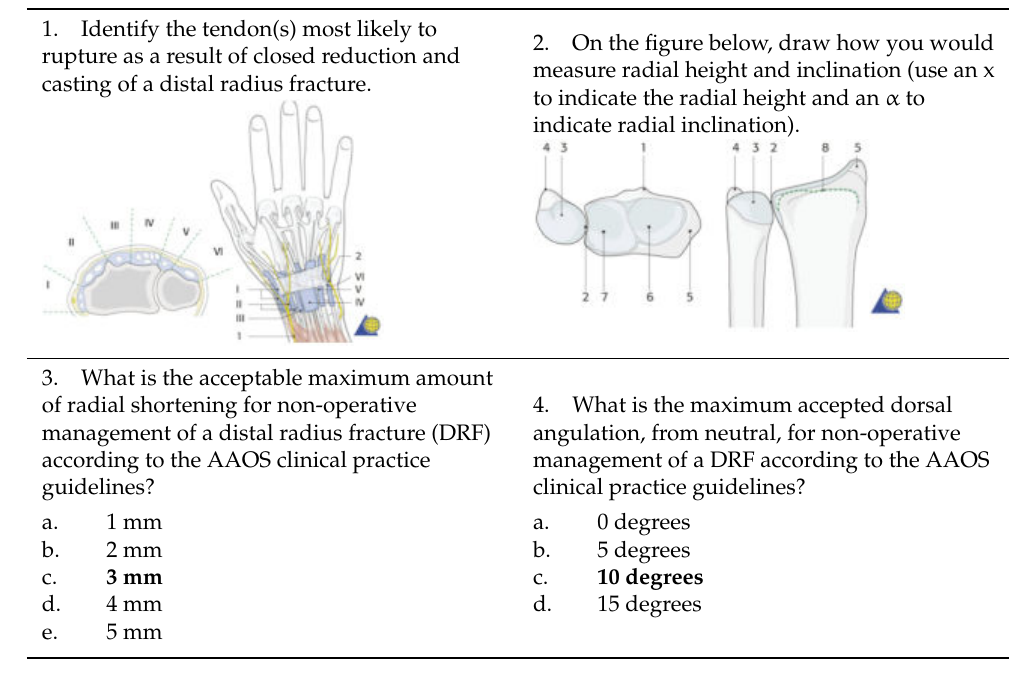
Table A1. Written examination given to trainees following the performance of distal radius fracture management on the phantom, correct responses to multiple choice questions are bolded, adapted from the work in